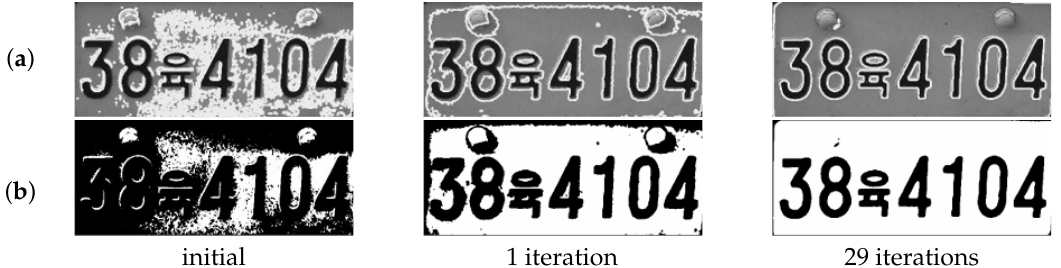
Figure 6. Korean car license plate image segmentation: ( a ) zero contour line with original image. ( b ) Segmented image.